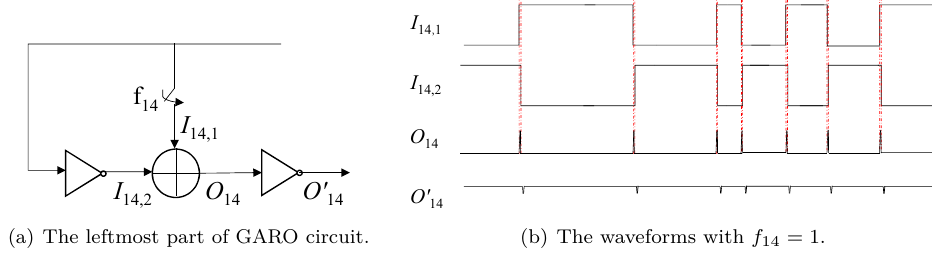
Figure 10: The leftmost part of GARO circuit and waveforms with f 14 =